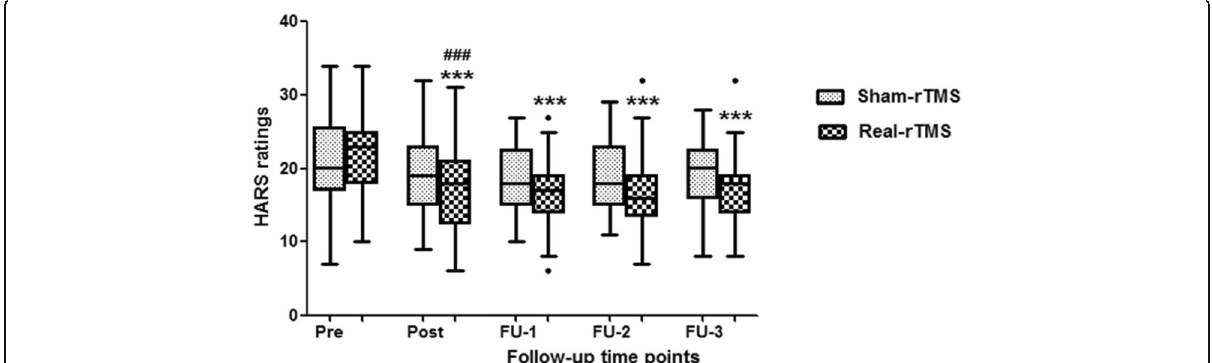
Fig. 3 : Effect of rTMS on pain related anxiety in FMS. Anxiety assessed by Hamilton anxiety rating scale (HARS) in Sham ( n = 41) and Real-rTMS ( n = 45) group at each time points;pre, post and follow up (FU-1 = 15 days, FU-2 = 3 months and FU-3 = 6 months post-rTMS). Hash (#) symbol indicates within group p value. Asterisk (*) symbol indicates p value between Sham-rTMS and Real-rTMSgroup. * p or # p < 0.05; ** p or ## p < 0.01; *** p or ### p < 0.001